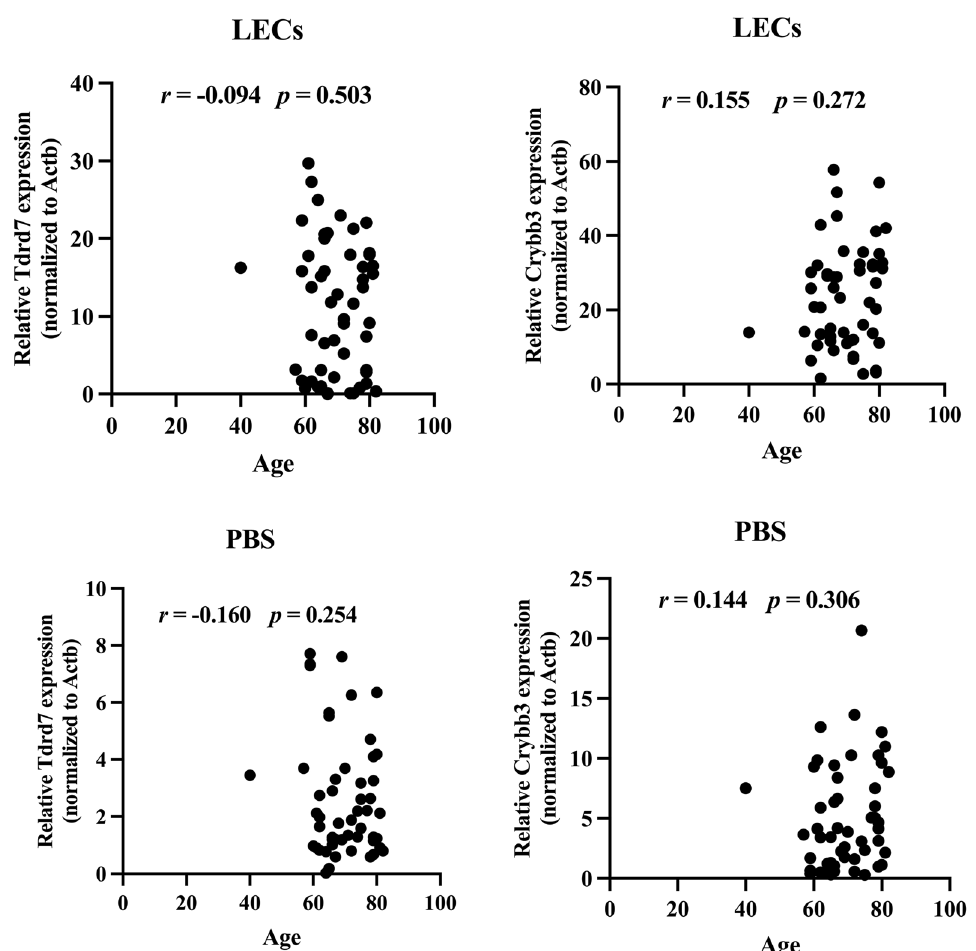
Fig. 6 Correlation analyses between age and genes, TDRD7 and CRYBB3 . LECs Lens Epithelial Cells, PBS Peripheral Blood